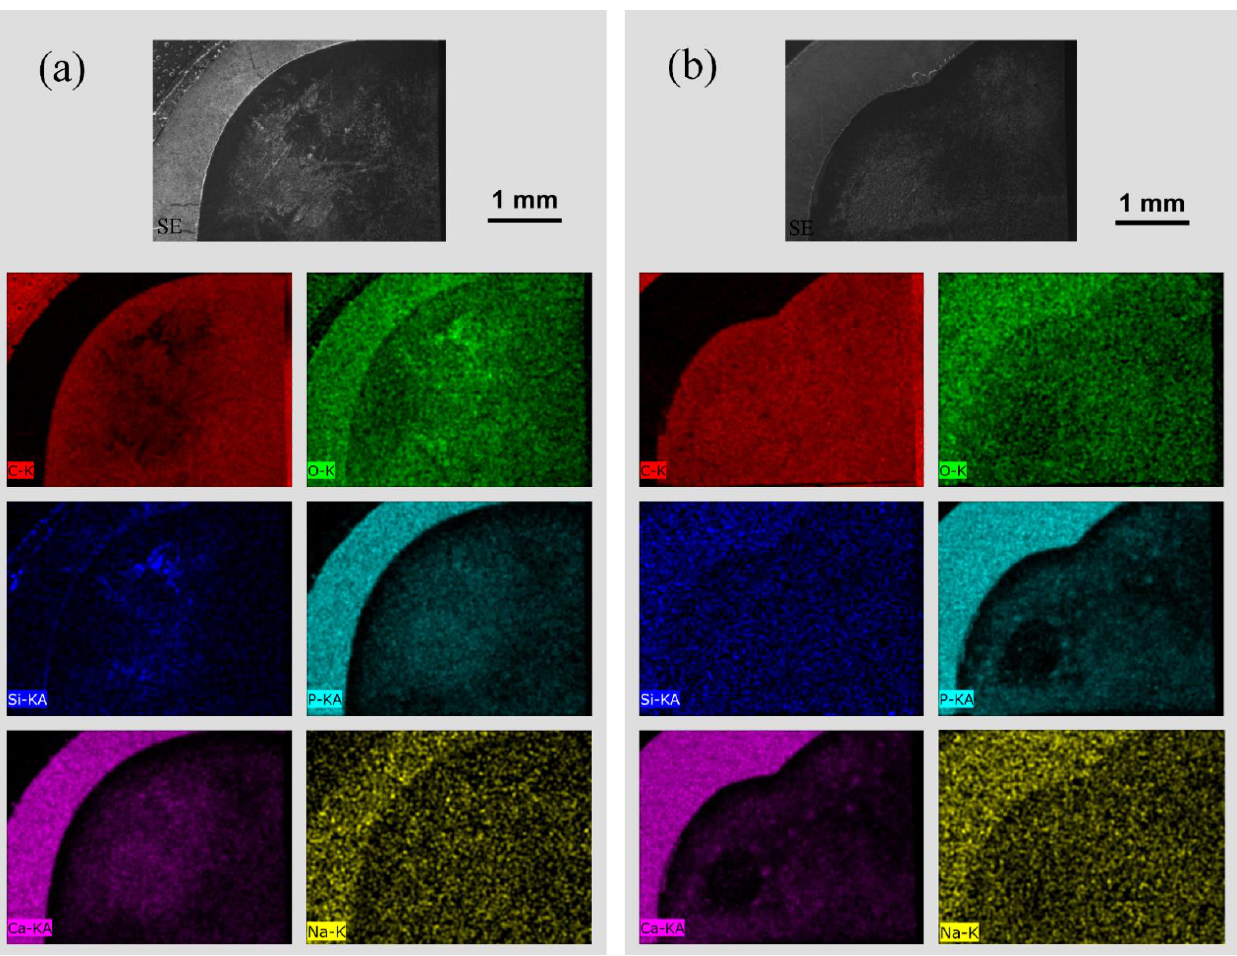
Figure 5. EDX analysis (mapping) of enamel and dentin samples: ( a ) test group treated with biorepair ® ; ( b ) non-treated control group. Top row shows SE-images of the enamel and dentin discs at 30 × magnification. Analysis of C, O, Si, P, Ca, and Na are presented in different colors. Saturated areas within the dentin indicate intense deposition.